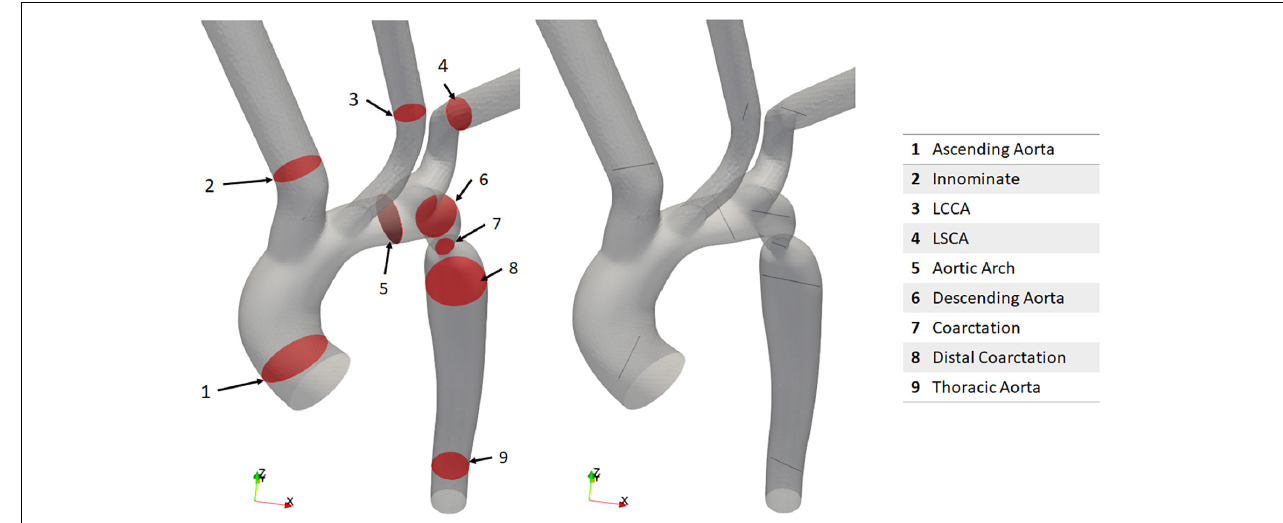
FIGURE 5 | The cross-sections, lines and their naming convention where pressure and velocity were assessed for grid